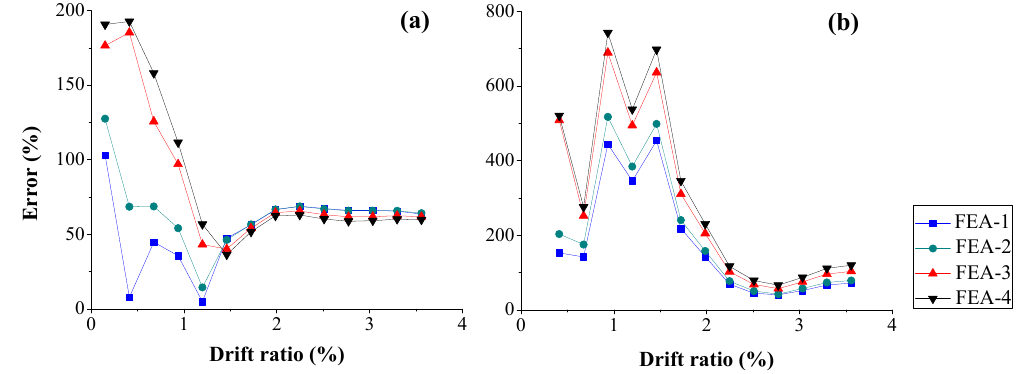
Figure 14. Root-mean-square error of rebar strain at different position along lateral loading direction: ( a ) − 149 mm; and ( b ) 149 mm.